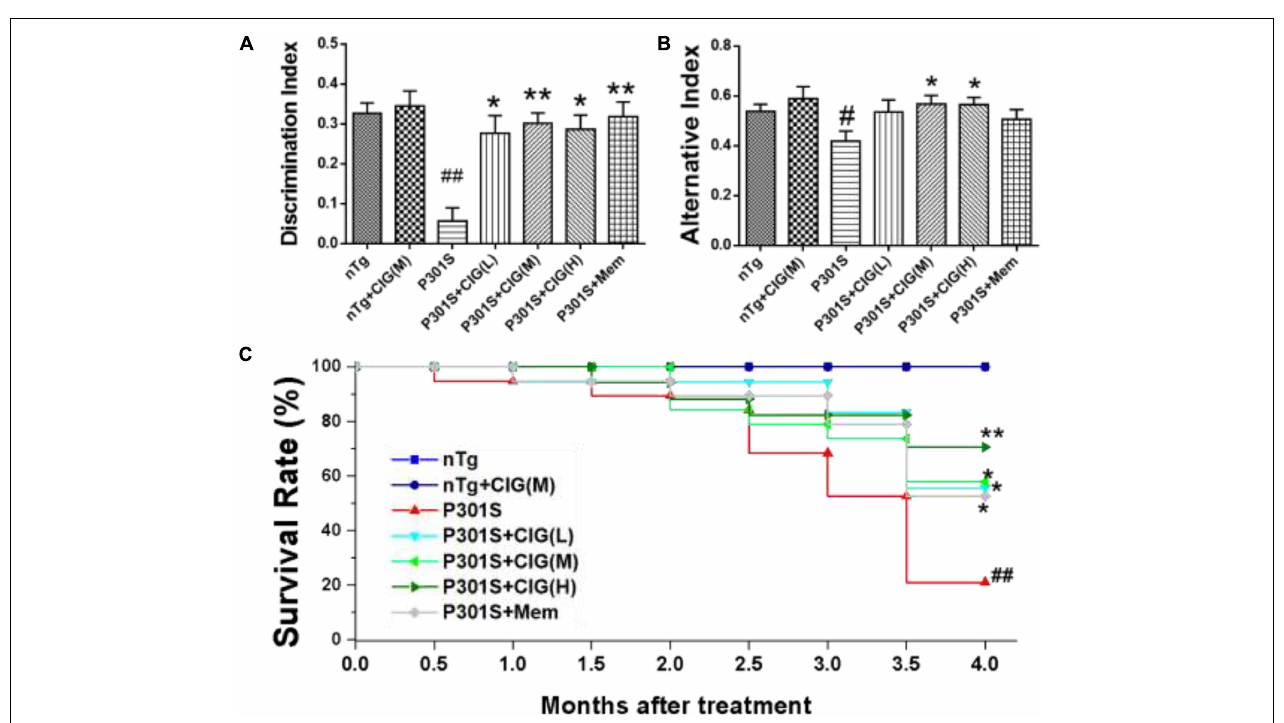
FIGURE 1 | Cornel iridoid glycoside (CIG) improved cognitive impairments and survival rate of P301S transgenic mice. CIG was intragastrically administered to P301S mice for 3.5 months. (A) Discrimination index (DI) in object recognition test. (B) Percentage of alternation behavior (alternation index) in the Y-maze test. (C) Survival rate of 9-month-old P301S mice after treatment. Data are expressed as mean ± SEM; n = 12–20 each group. # P < 0.05, ## P < 0.01, P301S transgenic mice vs nTg control mice; * P < 0.05, ** P < 0.01, drug-treated P301S mice vs saline-treated P301S mice. nTg, non-transgenic control mice; nTg + CIG(M), non-transgenic control mice treated with CIG (100 mg/kg, medium dose); P301S, vehicle-treated P301S mice; P301S + CIG(L), CIG (50 mg/kg, low dose)-treated P301S mice; P301S + CIG(M), CIG (100 mg/kg, medium dose)-treated P301S mice; P301S + CIG(H), CIG (200 mg/kg, high dose)-treated P301S mice; P301S + Mem, P301S mice treated with 5 mg/kg of memantine.